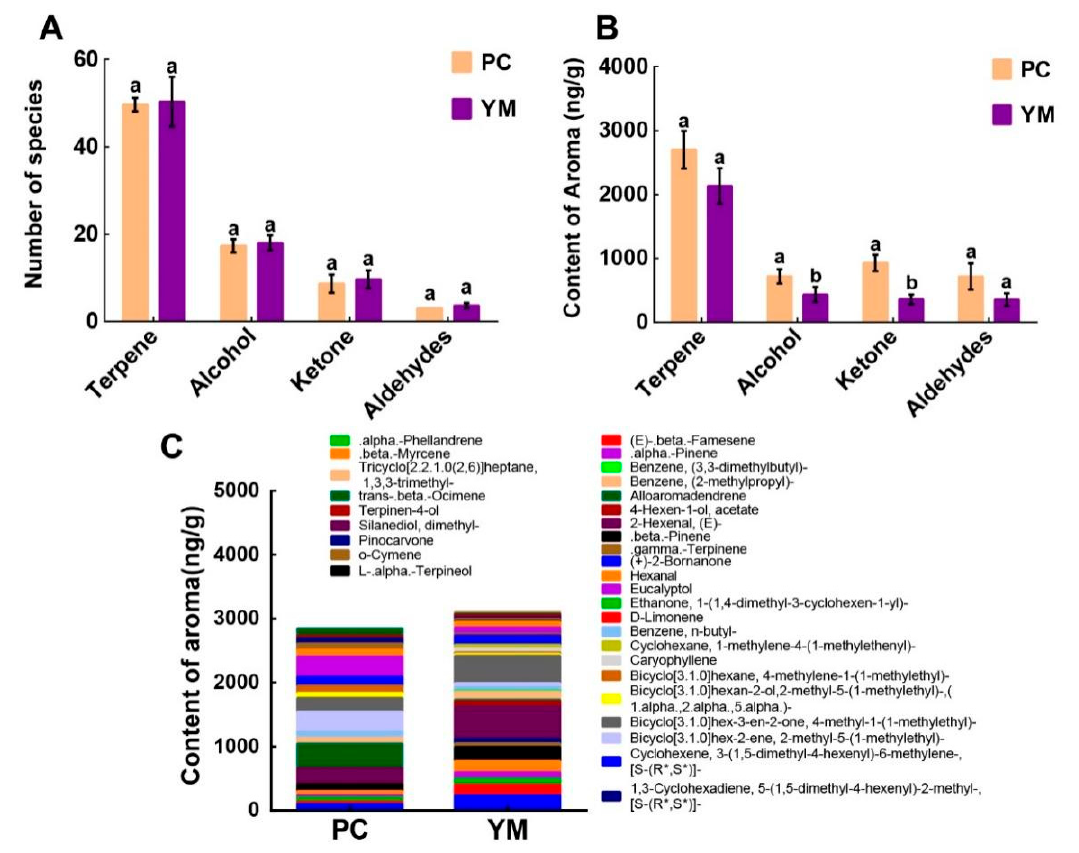
Figure 4. The analysis of aroma compounds in the ray florets of PC and YM at the full-bloom stage. ( A ) The number of species of four types of aroma compounds in ray florets of PC and YM. ( B ) The content of species of four types of aroma compounds in ray florets of PC and YM. ( C ) The content of the specific aroma components in ray florets of PC and YM. Table 1. The content of flavor compounds in fresh flowers of PC and YM.